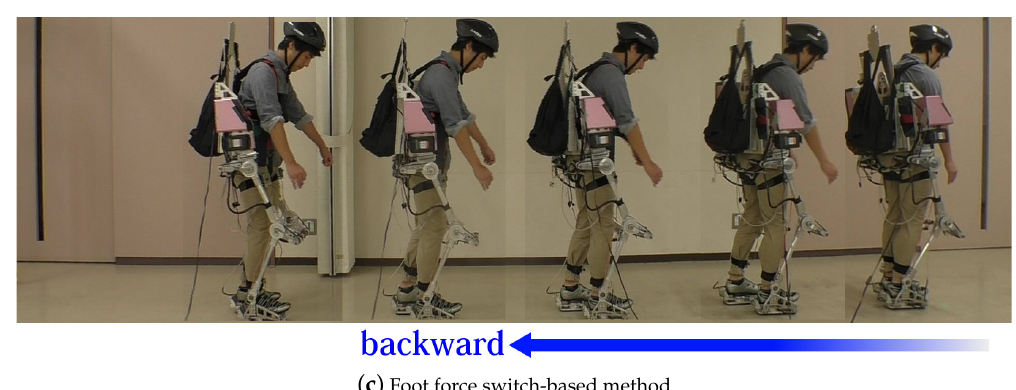
Figure 9. Image sequences of walking backward based on each method: the sampling time of the image capture was approximately 5.4